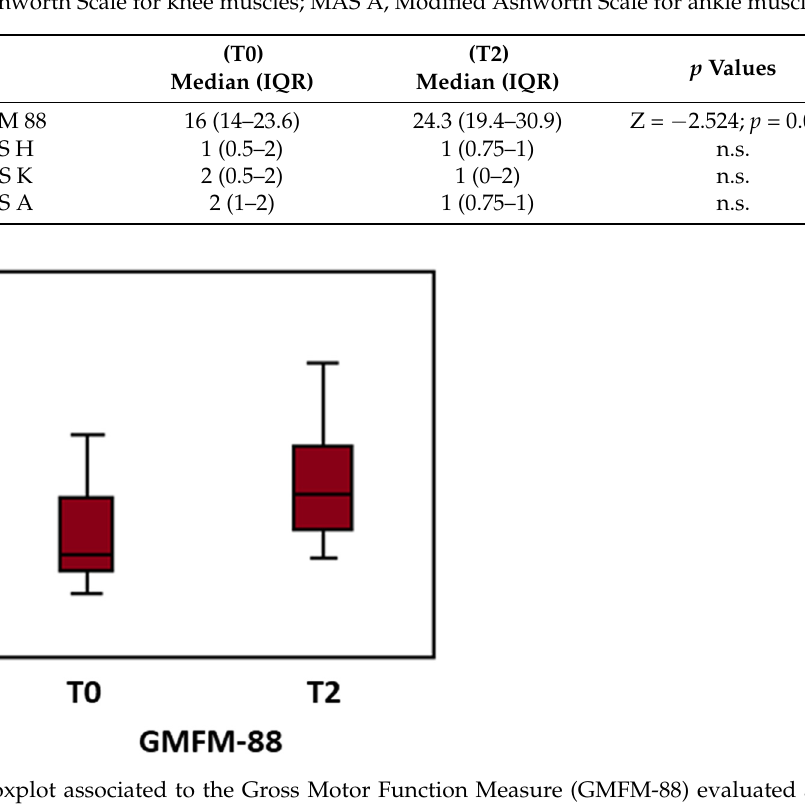
Table 3. GMFM-88 improvement for each participant between T0 and T2 in response to RAGT. Subj